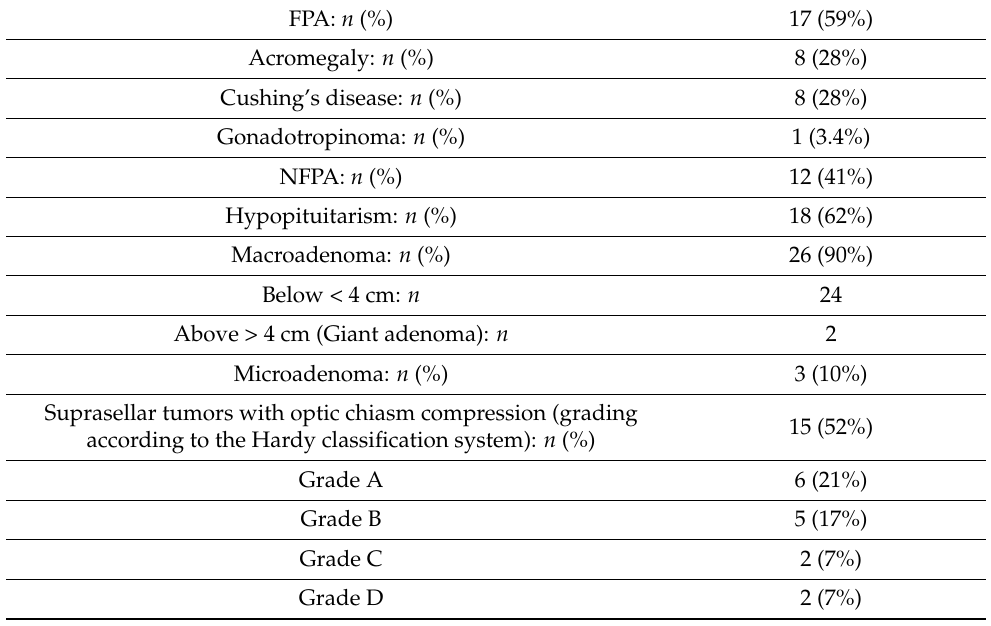
Table 1. Baseline clinical characteristics of